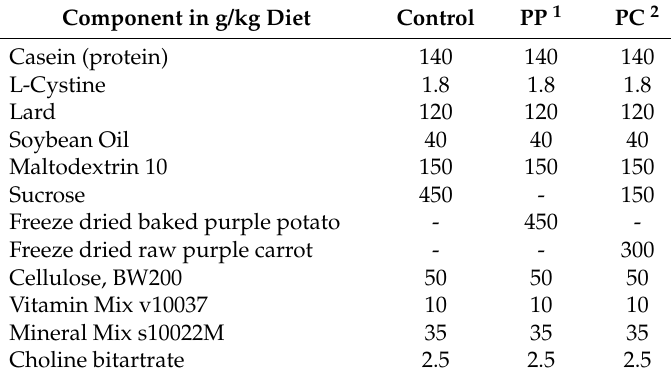
Table 1. Composition of the experimental